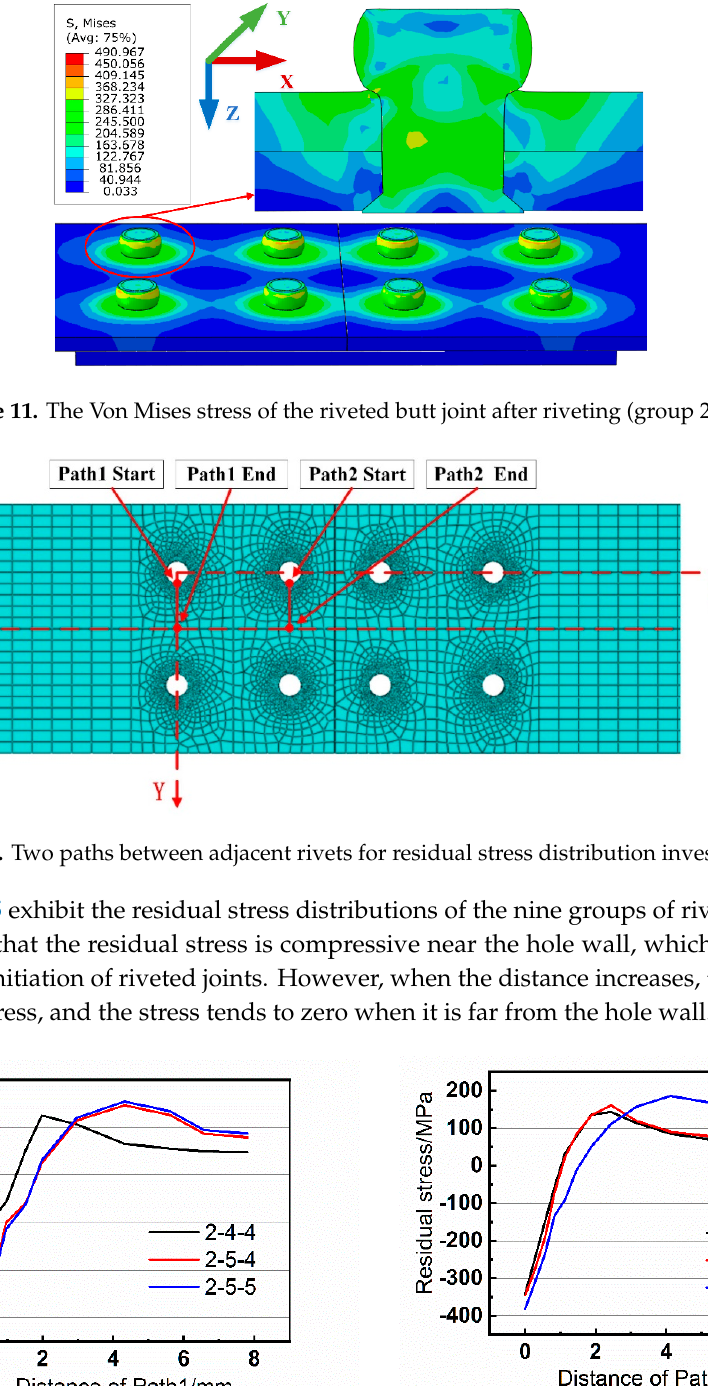
Figure 11. The Von Mises stress of the riveted butt joint after riveting (group 2-5-4).